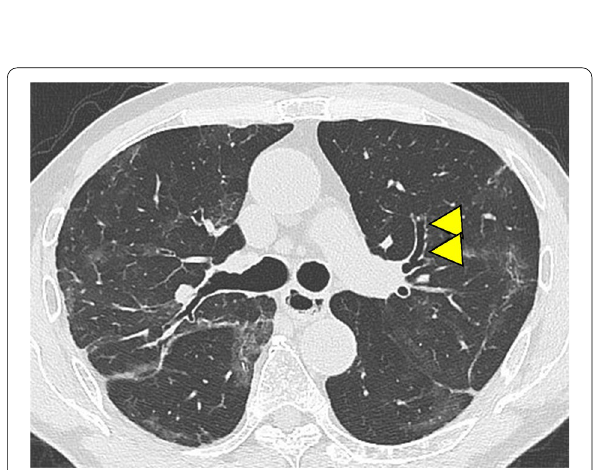
Fig. 5 CT score at 1-month follow-up. The GGO scores of the patients receiving steroid therapy after 14 days were significantly higher than those of the patients who received steroid therapy before 14 days (score: 8.6 vs 5.3, p =